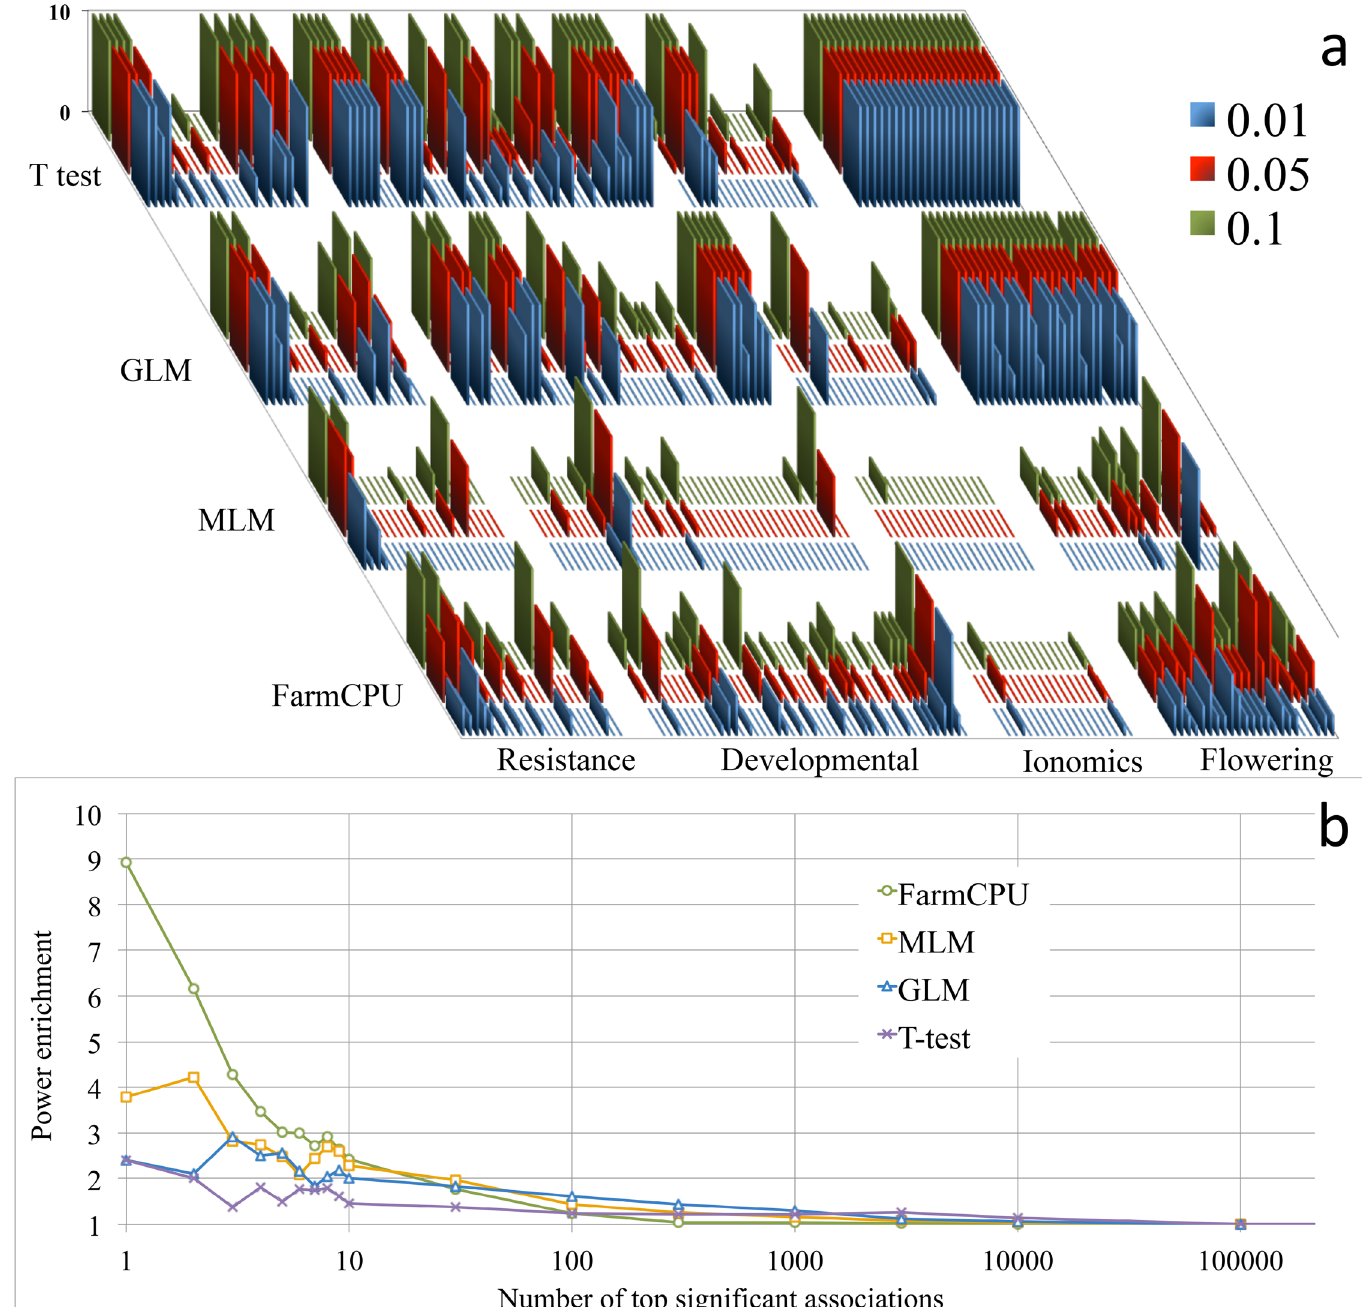
Fig 2. Reanalysis of 107 traits and power enrichment evaluation on 23 flowering time traits in Arabidopsis thaliana . Four methods were employed to reanalyze the 107 traits of 199 Arabidopsis thaliana samples genotyped at 250,000 SNPs (a) , including a na ï ve method (t-test), GLM, MLM, and FarmCPU. The first three PCs were included in the GLM and MLM to control population structure. FarmCPU did not use any PCs. The horizontal axis indicates the 107 traits grouped into four categories: resistance, developmental, ionomics, and flowering time. The vertical axis indicates the number of associated SNPs at three significance levels (0.01, 0.05 and 0.1) after Bonferroni multiple test corrections. The previous results were replicated by using the na ï ve and MLM methods. The na ï ve method, without any control on population structure and kinship, generates many associated SNPs. The associations due to genetic linkage to known genes are indistinguishable from the background noise. In contrast, the MLM method controls the inflation of P values well; however, the associations due to genetic linkage to known genes are also weakened and indistinguishable from the background. The GLM method generates results that are between the na ï ve method and the MLM method. Interestingly, for each flowering time trait, FarmCPU revealed multiple genetic loci. Enrichment analysis was performed to evaluate the four statistical methods (b) on the 23 flowering time traits by using flowering time genes. The random hits are expected to have